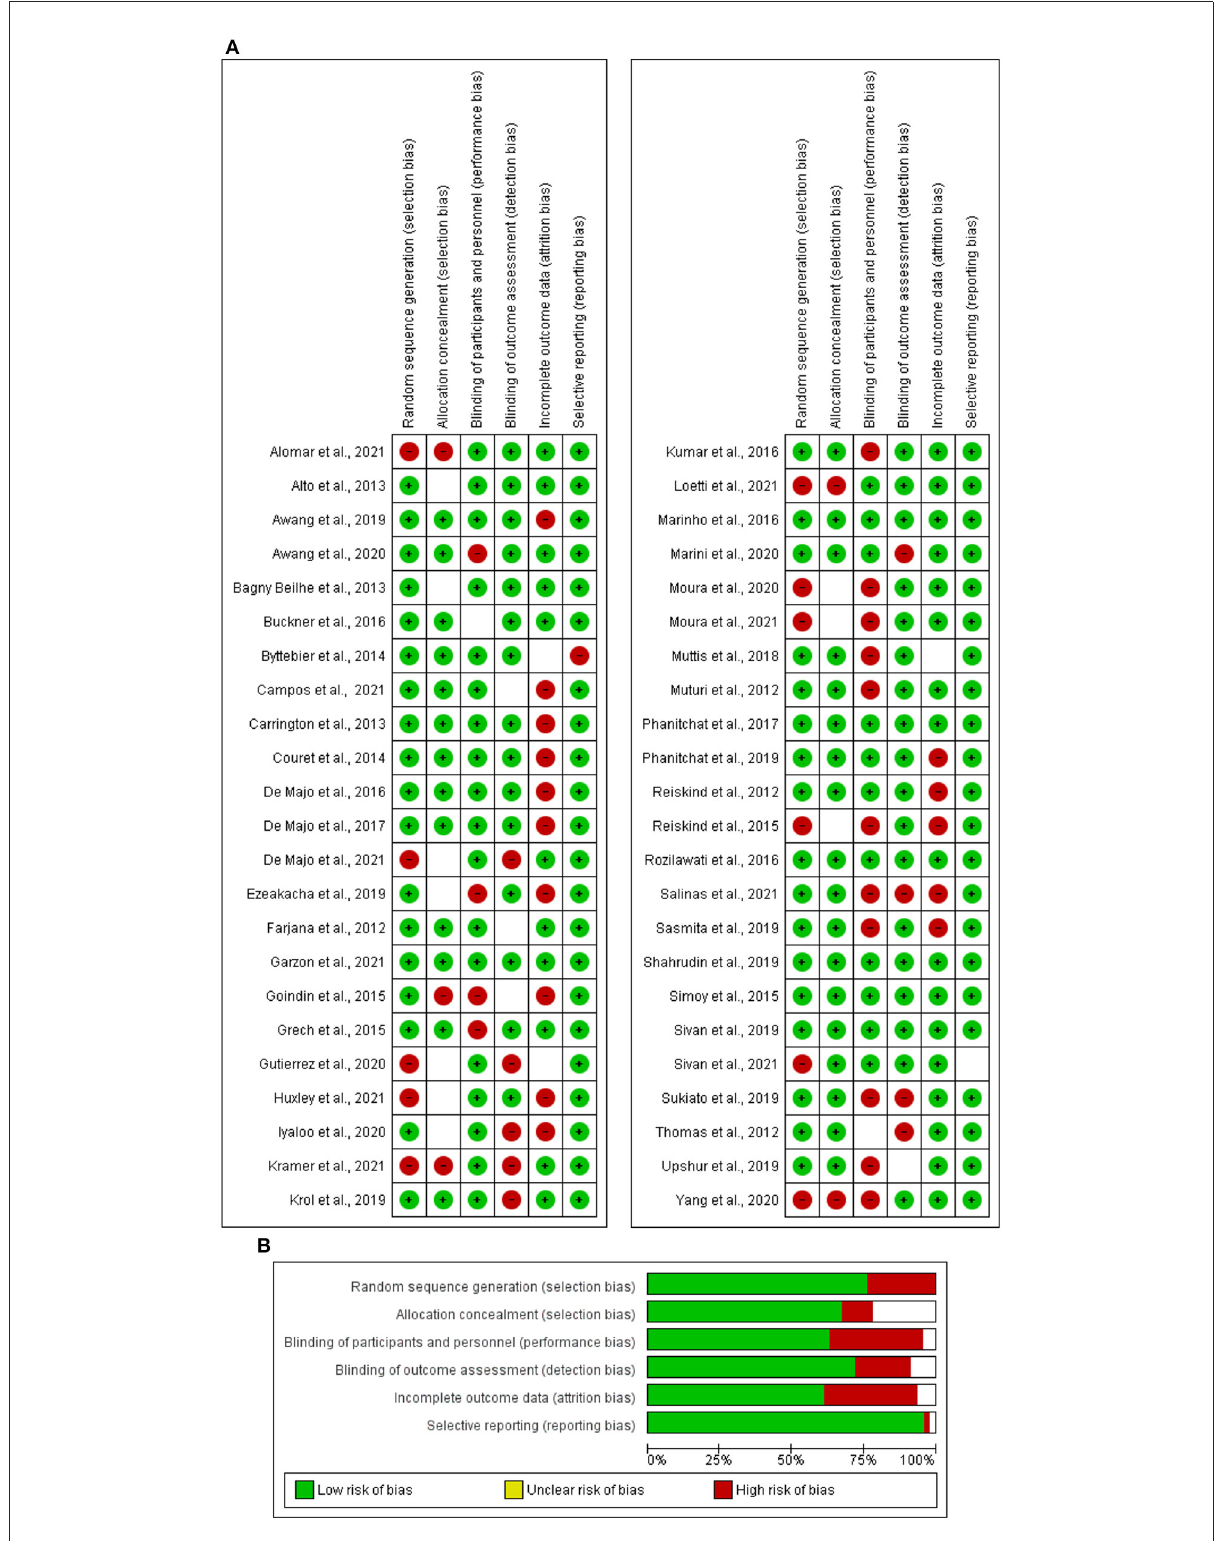
FIGURE2 (A) Summary of risk of bias based on traffic light plot. (B) Graph of risk of